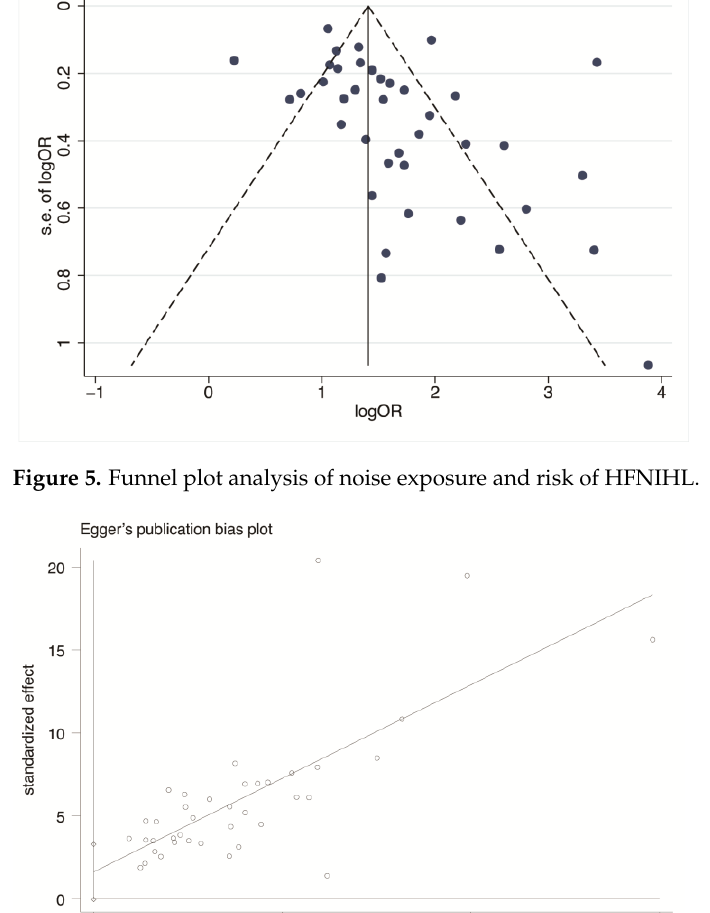
Figure 6. Egger linear regression test of noise exposure and risk of HFNIHL.